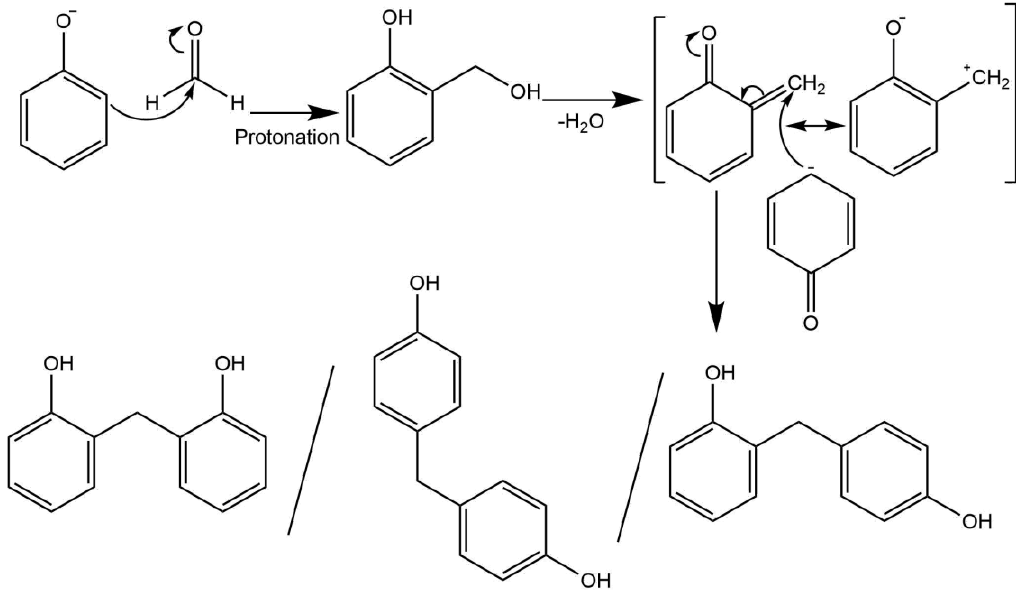
Figure 2. Polycondensation mechanism phenol and formaldehyde reacting via a quinone methide intermediate to form a methylene bridge. Possible products from left to right: o-o’ , p-p’ , o-p’ .